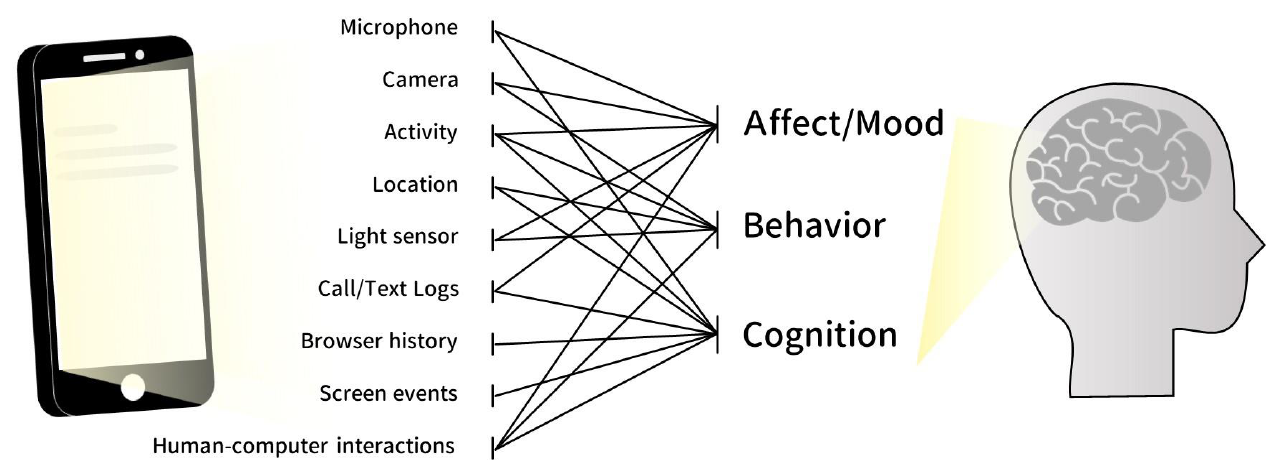
Figure 2. Smartphone hardware and software offer valuable sources of digital biomarkers that reflect users’ moods, behaviors, and cognitions at any point in time. These sources include microphones, cameras, activity and location monitors, light sensors, call or text logs, browser history, screen events, and human–computer interactions.